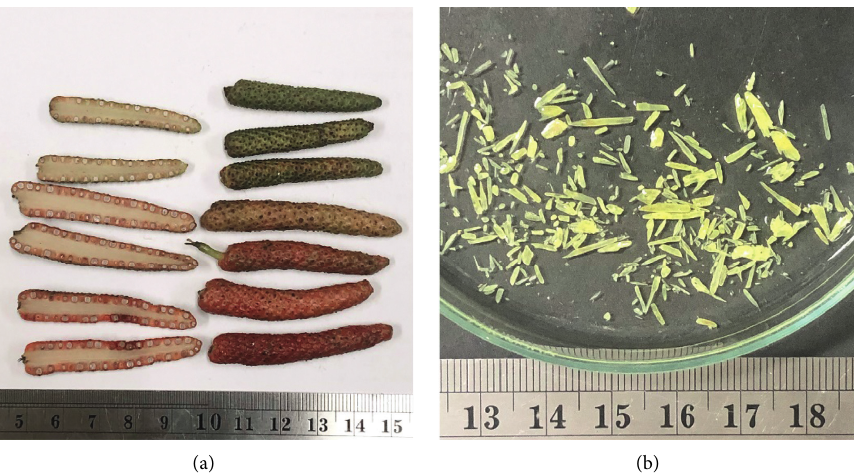
Figure 2: The multiple fruit of P. retrofractum Vahl when ripe changes to a red-orange color and consists of many minuscule seeds embedded in the same receptacle (a). The column chromatography shows purified pale yellow needle-like crystal 3–12mm alkaloid from dichloromethane and isopropanol extraction of P. retrofractum Vahl (b). Table 1: Percent yield of crude extract from P. retrofractum by several solvent extraction.